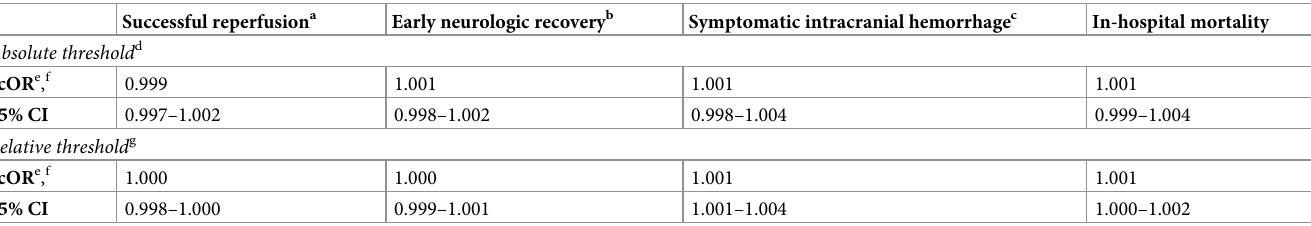
Table 4. Association between area under the threshold and secondary safety